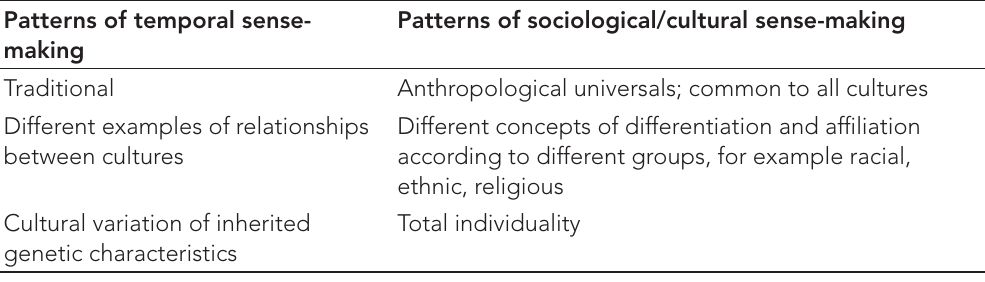
Patterns of sociological/cultural sense-making Different concepts of differentiation and affiliation according to different groups, for example racial, ethnic, religious Total